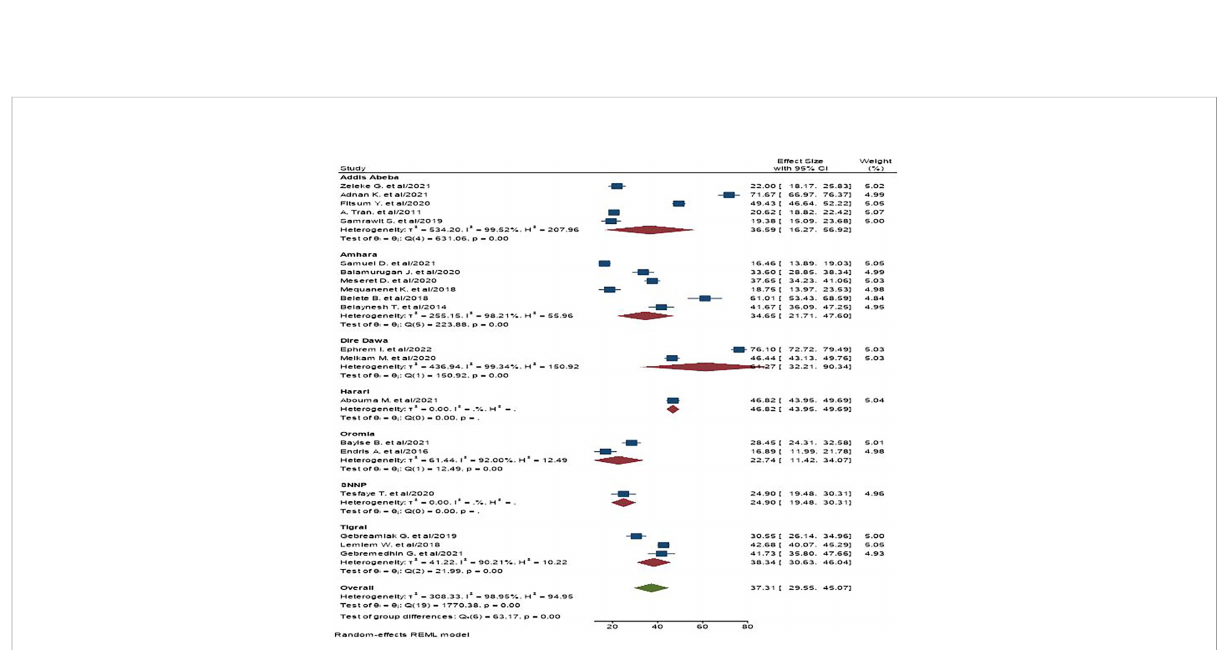
FIGURE 3 The pooled prevalence of central obesity among adult populations based on region the study is conducted in Ethiopia.